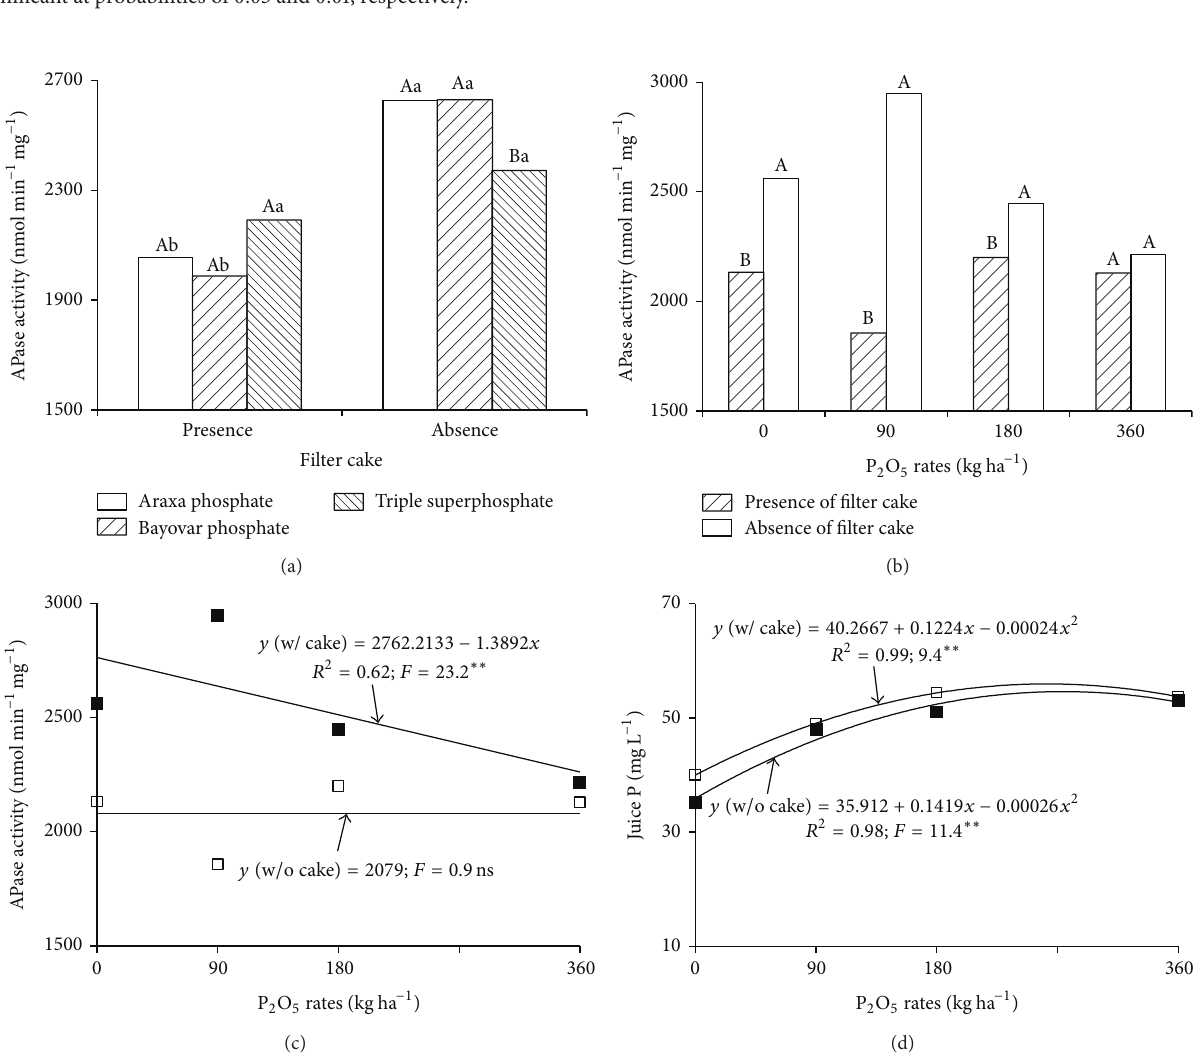
Figure 3: Leaf phosphorus in sugarcane at four months (a) and at 8 months (b), as a function of phosphorus application rate. ∗ and ∗∗ : significant at probabilities of 0.05 and 0.01, respectively.